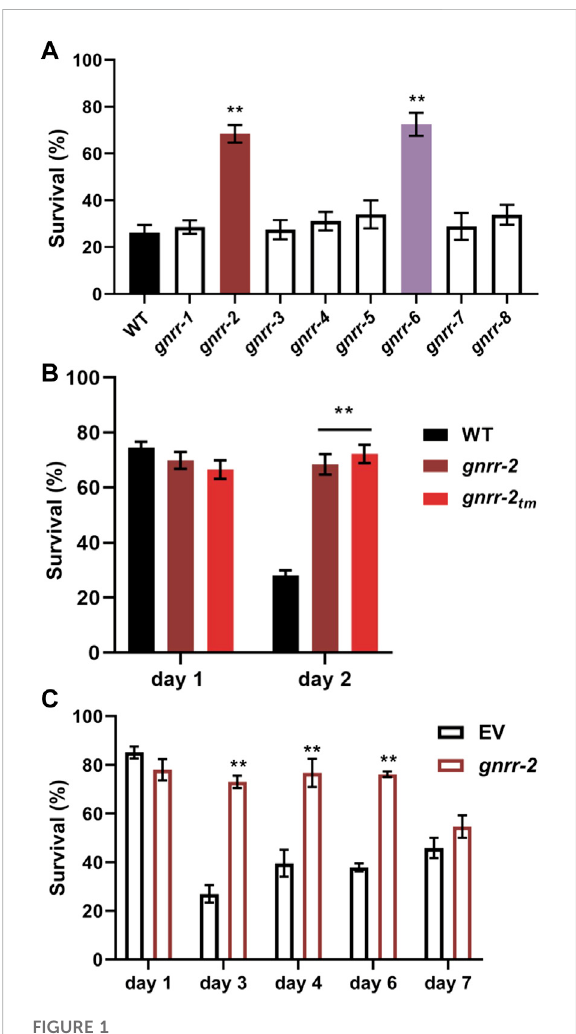
FIGURE 1 Gonadotropin-related hormone receptors gnrr-2 and gnrr-6 modulate HS survival in adulthood. (A) HS Survival rates of age-synchronized WT or gnrr-1 to gnrr-8 mutant